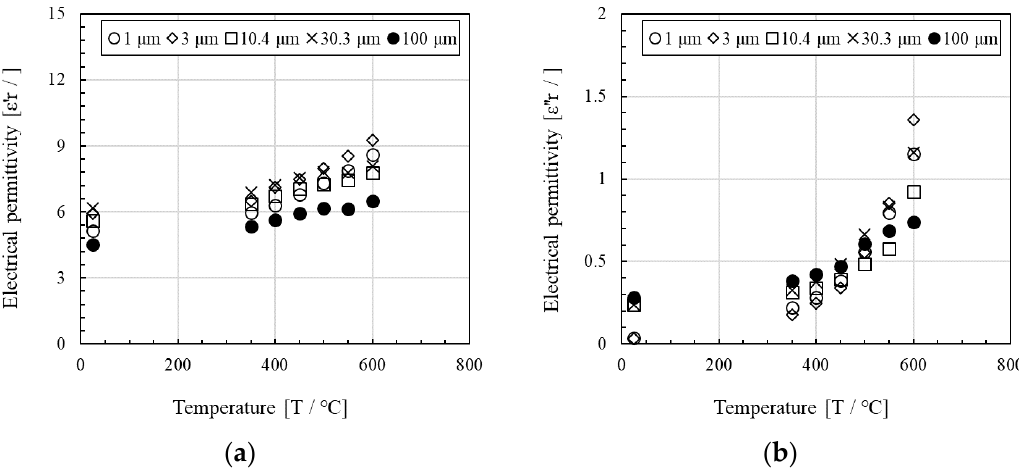
Figure 4. Plots of temperature vs. the ( a ) real and ( b ) imaginary relative electrical permittivity of Al 4 SiC 4 samples with various particle radii (1, 3, 10.4, 30.3, and 100 µ m). Experiments were conducted in a 6N N 2 atmosphere, and the sample densities were 1.0–1.8 g/cm 3